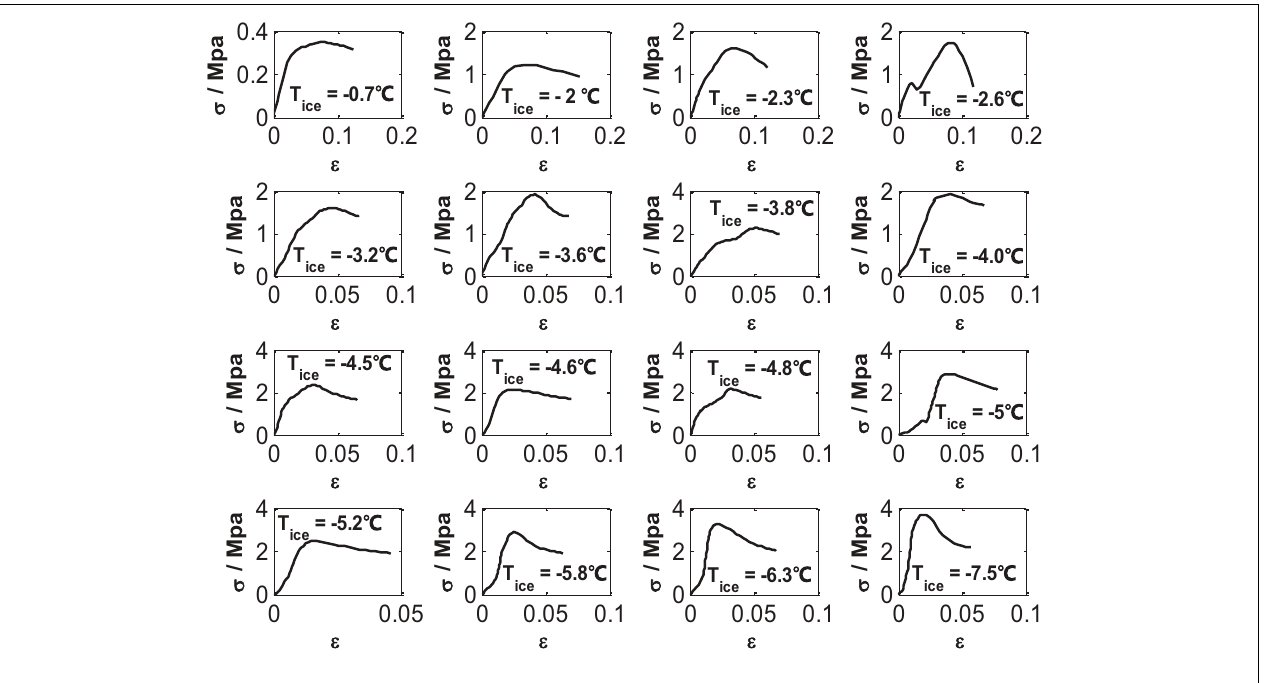
FIGURE 6 | Stress–strain curve of ice during compression process for different temperatures.